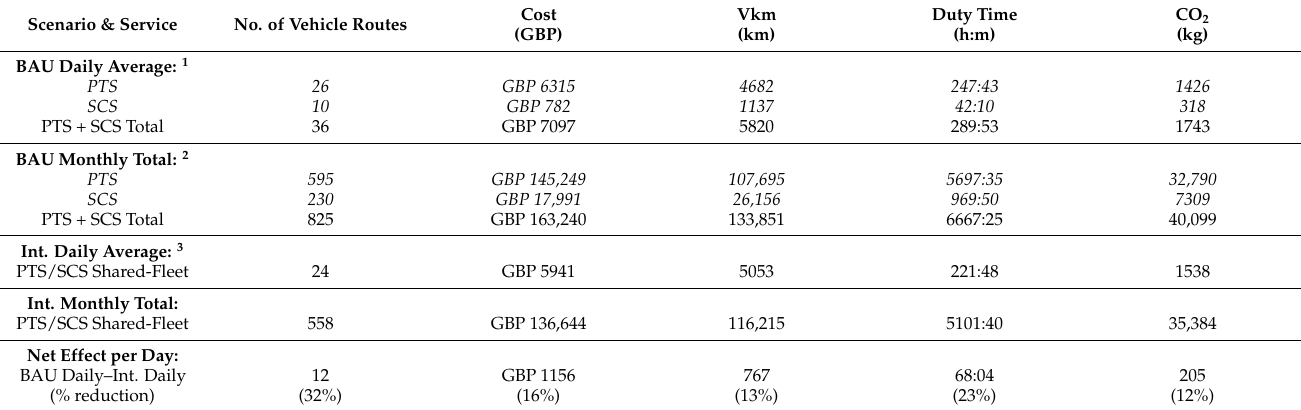
Table 3. Summary statistics for PTS and SCS in both BAU and intervention